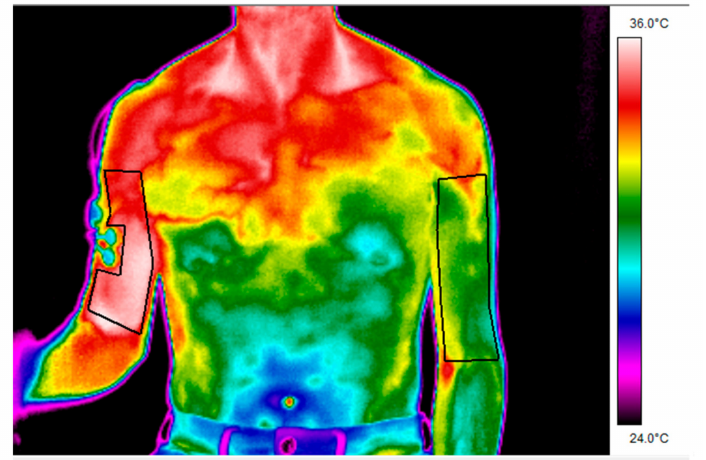
Figure 2. Regions of interest in which skin temperature was determined using infrared